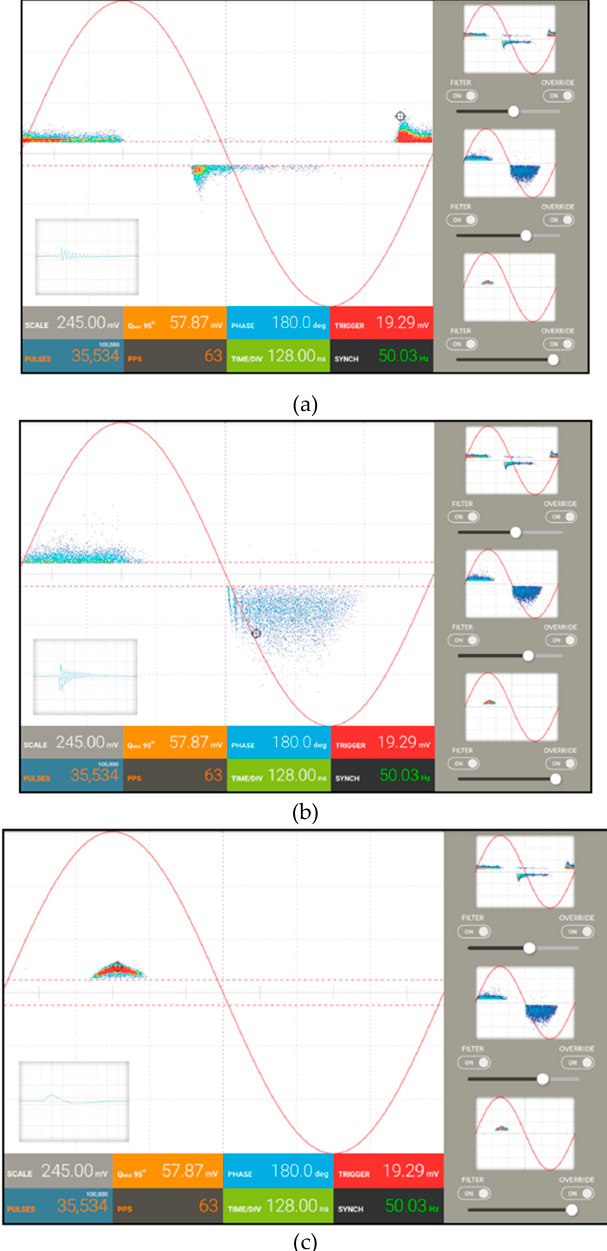
Figure 16. Filter applications on the acquired PD pattern in order to distinguish ( a ) internal, ( b ) surface, and ( c ) corona discharges.